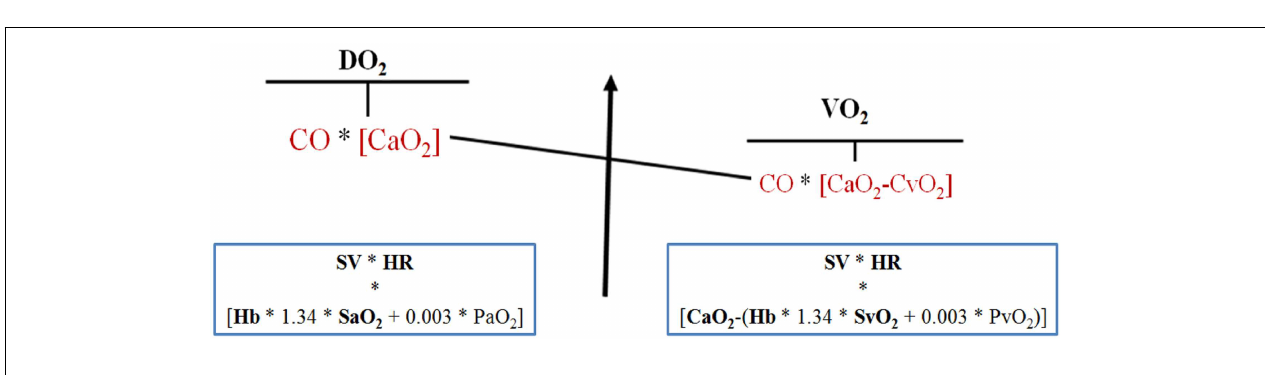
CaO 2 , arterial oxygen content,VO 2 ; oxygen consumption, SvO 2 ; hemoglobin mixed venous oxygen saturation; PvO 2 , venous oxygen partial pressure; CvO 2 , venous oxygen